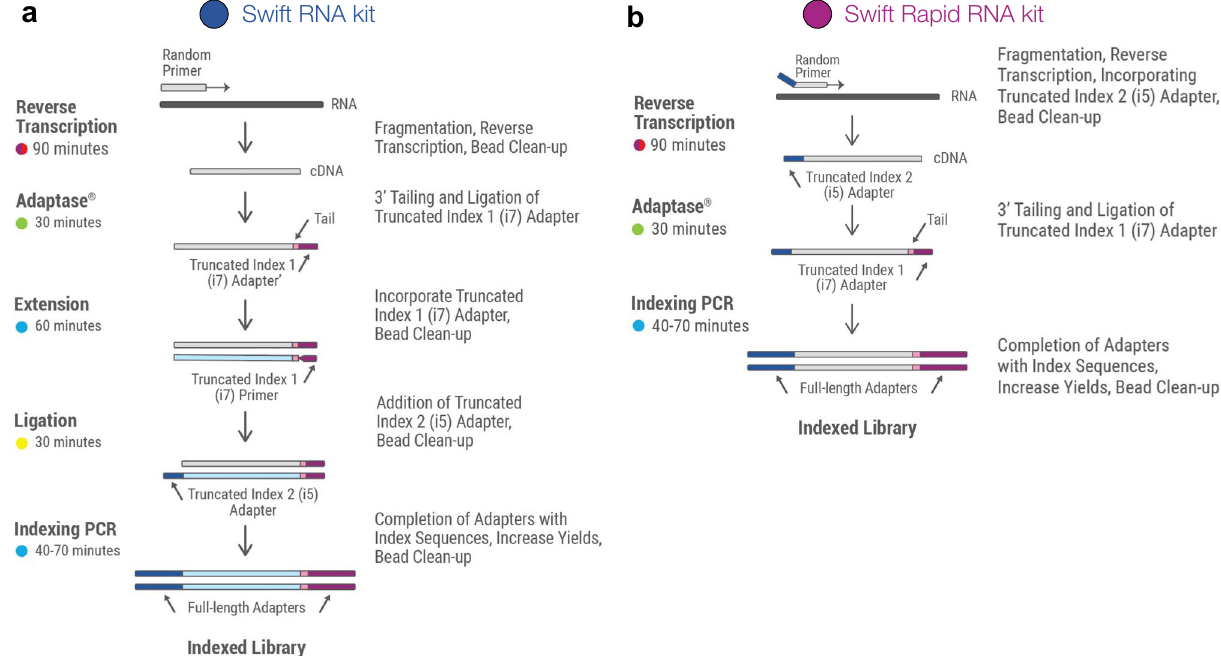
Figure 1. Workflows for library preparation using ( a ) the Swift RNA kit and ( b ) the Swift Rapid RNA kit. RNA Library kit RNA type Input (ng of total RNA) Library